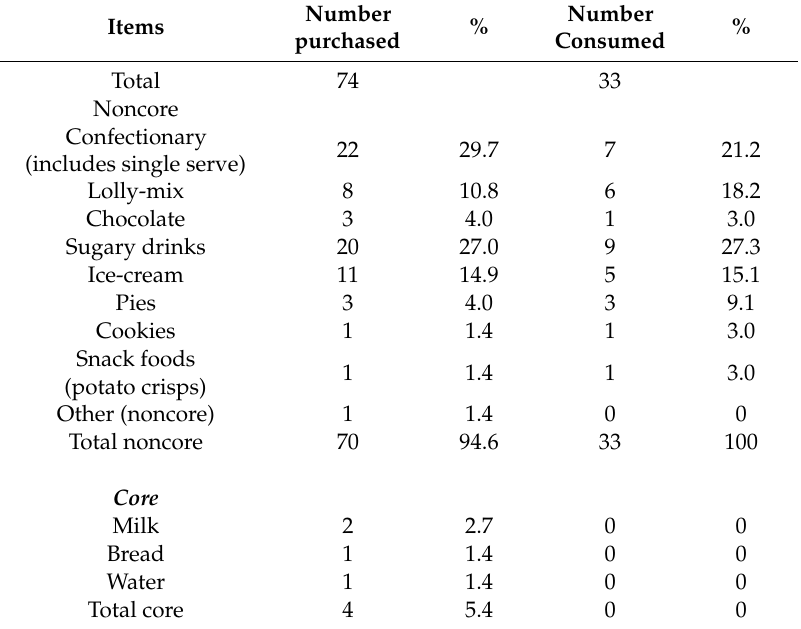
Table 4. Purchases and consumption of food and drinks from convenience